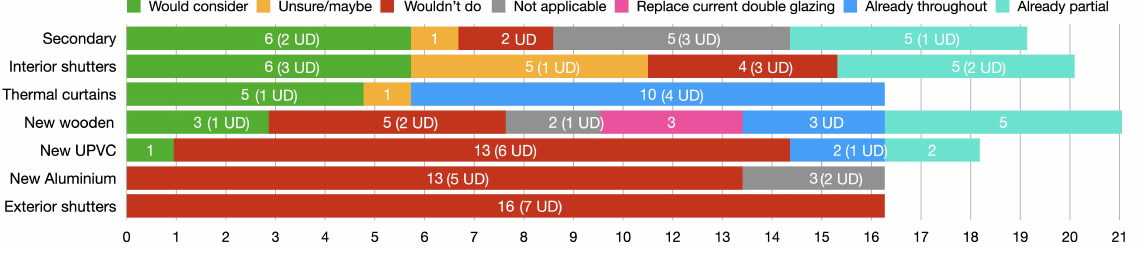
Figure 3. Acceptability of fenestration